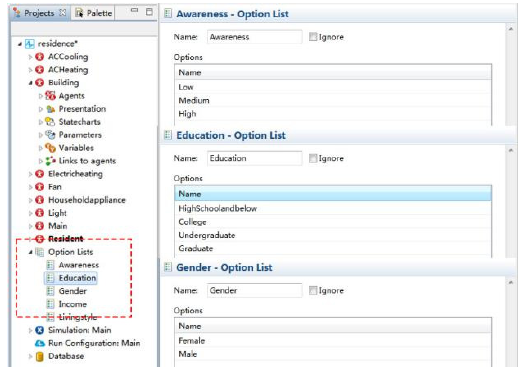
Figure 3. Personal characteristic option settings of resident agent.